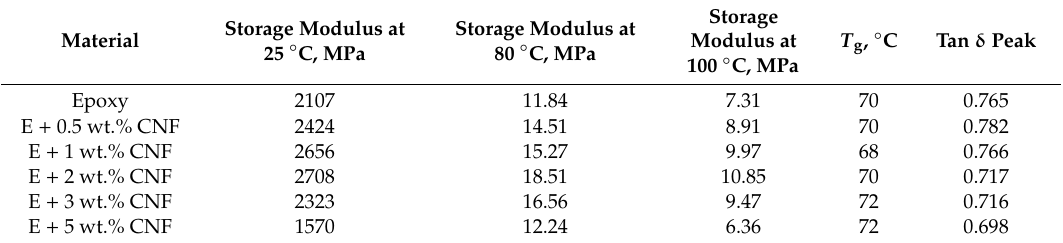
Table 3. DMA properties of unfilled epoxy and CNF-filled epoxy nanocomposites.